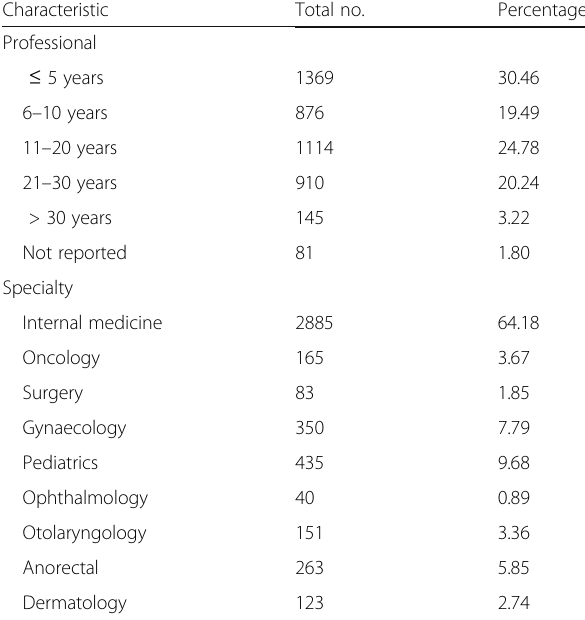
Table 1 Characteristics of 4495 survey respondents Characteristic